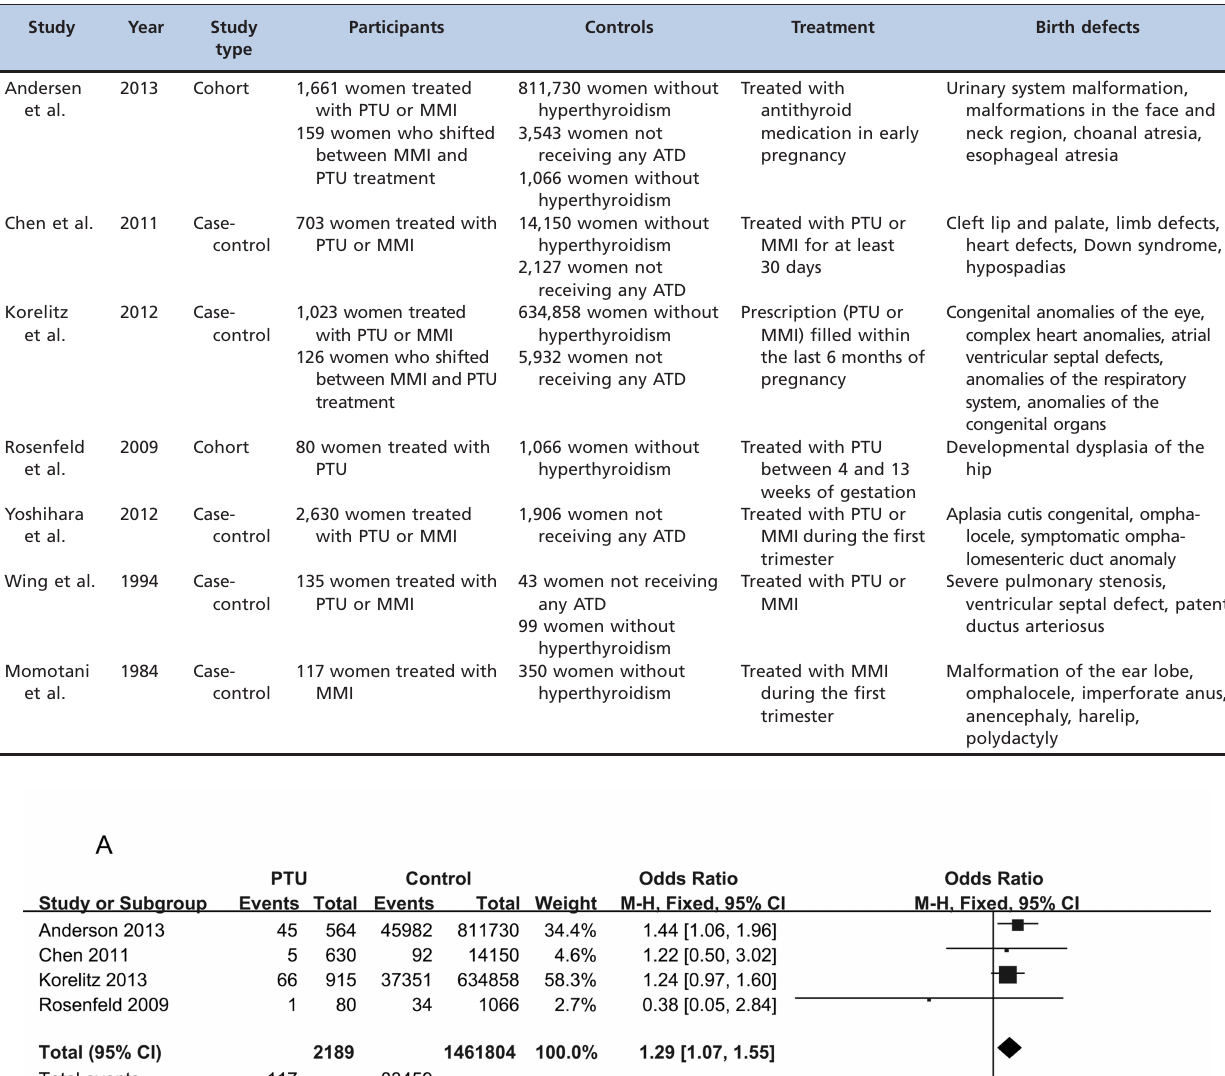
Table 1 - Characteristics of the 7 studies included in the review.